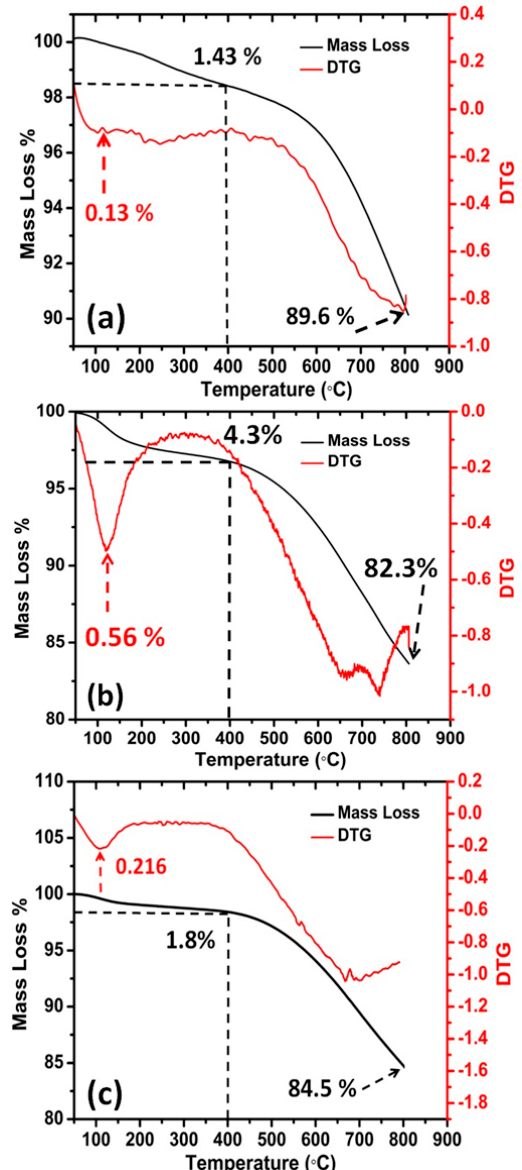
Figure 5. Thermo-gravimetric analysis (TGA) thermograms of: ( a ) MWNTs (Aldrich), ( b ) CNTs treated with hydrogen peroxide, and ( c ) treated with hydrogen peroxide then acetone.